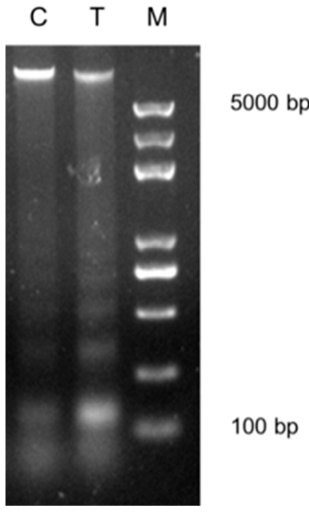
Figure 1. Effects of vitamin C (Vc) treatment on the higher-order chromatin structure in somatic cell nuclear transfer (SCNT) donor cells. Donor nuclei were digested with MNase under the same conditions for both the control cells (C) and the Vc-treated cells (T). DNA marker (M) was